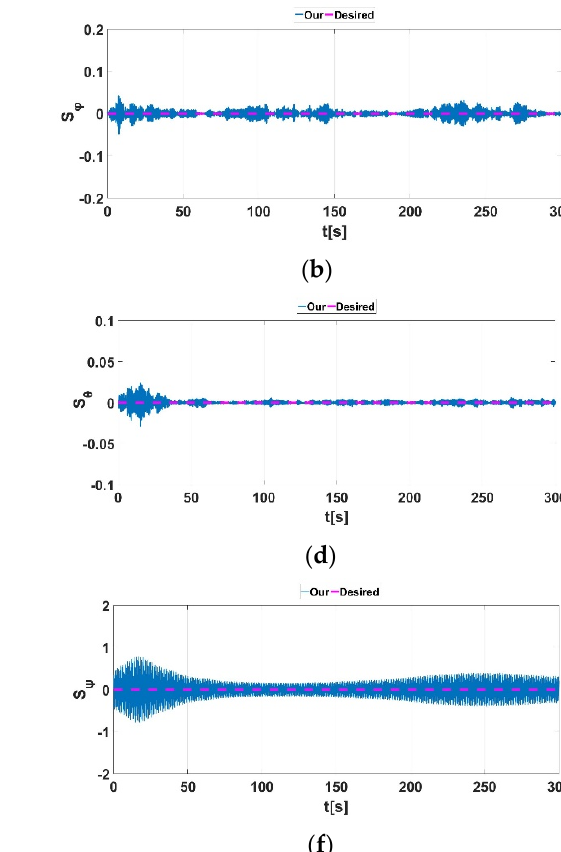
Figure 13. AUV velocity − tracking errors. ( a ) 𝑢 𝑒 ; ( b ) 𝑝 Table 4. Average values of 𝐷 𝐸 .